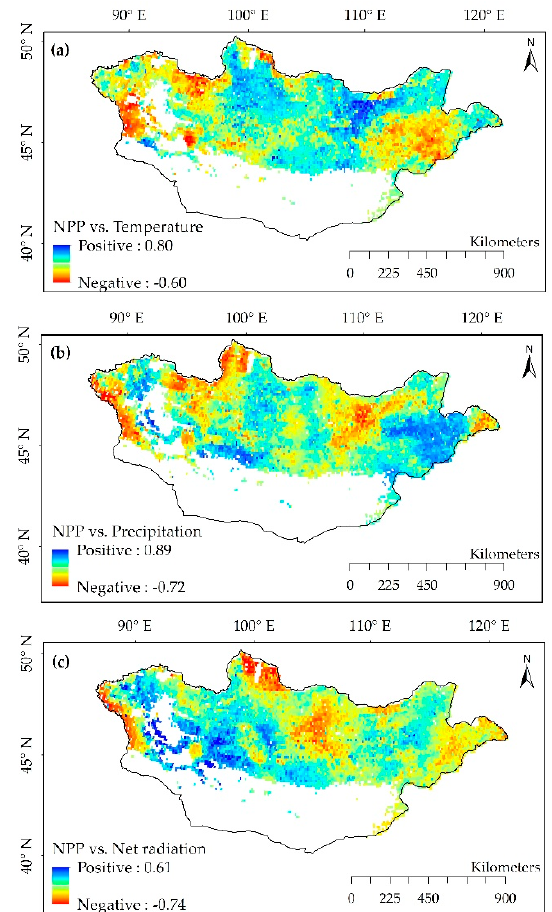
Figure 8. Spatial correlation coefficients between annual NPP and ( a ) temperature, ( b ) precipitation, and ( c ) net radiation from 2003 to 2018.